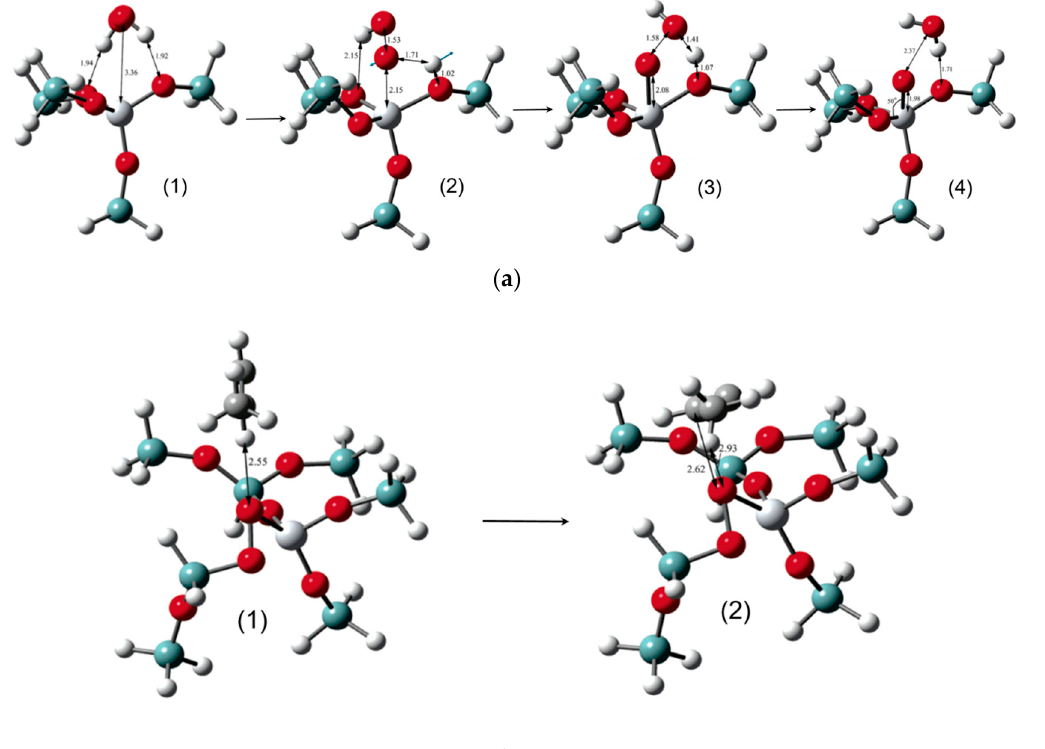
Figure 4. Munakata et al. mechanism: ( a ) the formation of Si–O–O–Ti species, where (1) is the preadsorbed complex of H 2 O 2 on TS-1, (2) is the transition-state geometry for the first step in oxygen insertion to the peroxo intermediate on the closed Ti site, (3) is the stable intermediate geometry prior to the second step in oxygen insertion to the peroxo intermediate, and (4) is the transition-state geometry for the second step in oxygen insertion to the peroxo intermediate; ( b ) propylene epoxidation, where (1) is the preadsorbed complex of propylene with the peroxo intermediate on the closed Ti site in TS-1, and (2) is the transition-state geometry during the propylene epoxidation [104]. Distances shown are in units of angstroms. Copyright © 2006 American Chemical Society.